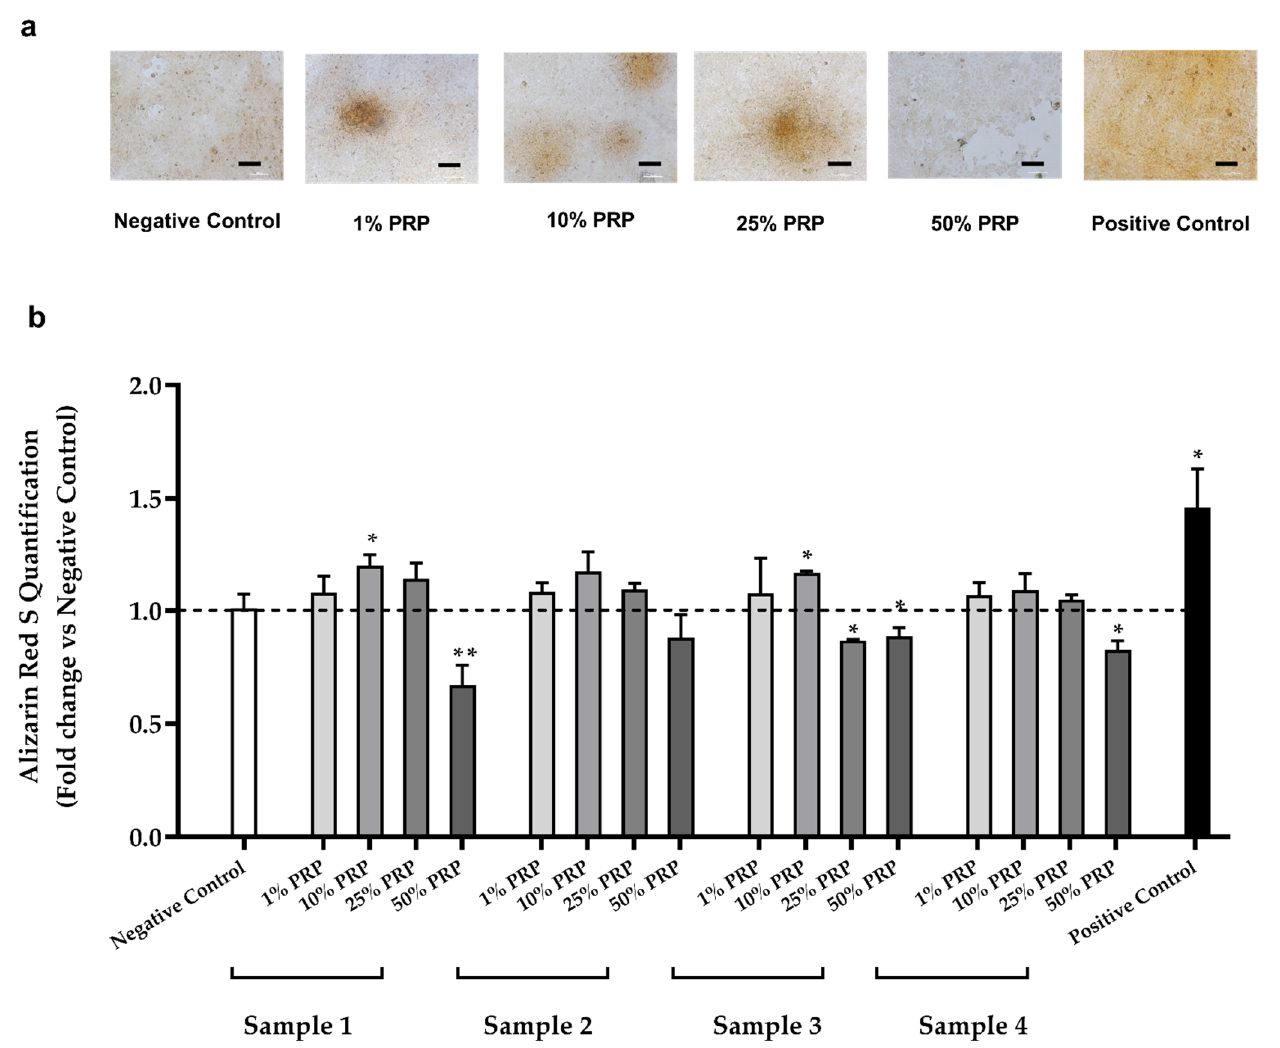
Figure 4. Calcium deposition in the extracellular matrix induced by PRP treatment. ( a ) Optical microscopy images of HOB-01-C1 cells treated with different PRP dilutions (1–50%) and stained at T14 with Alizarin Red S (10 × ) Scale bar 100 µ m; ( b ) Alizarin Red S staining quantification with different PRP dilutions at T14. Data are reported as fold change vs. negative control and expressed as mean ± SD of three independent experiments. Statistical analysis was performed by one-way ANOVA test (* p < 0.05; ** p < 0.01).